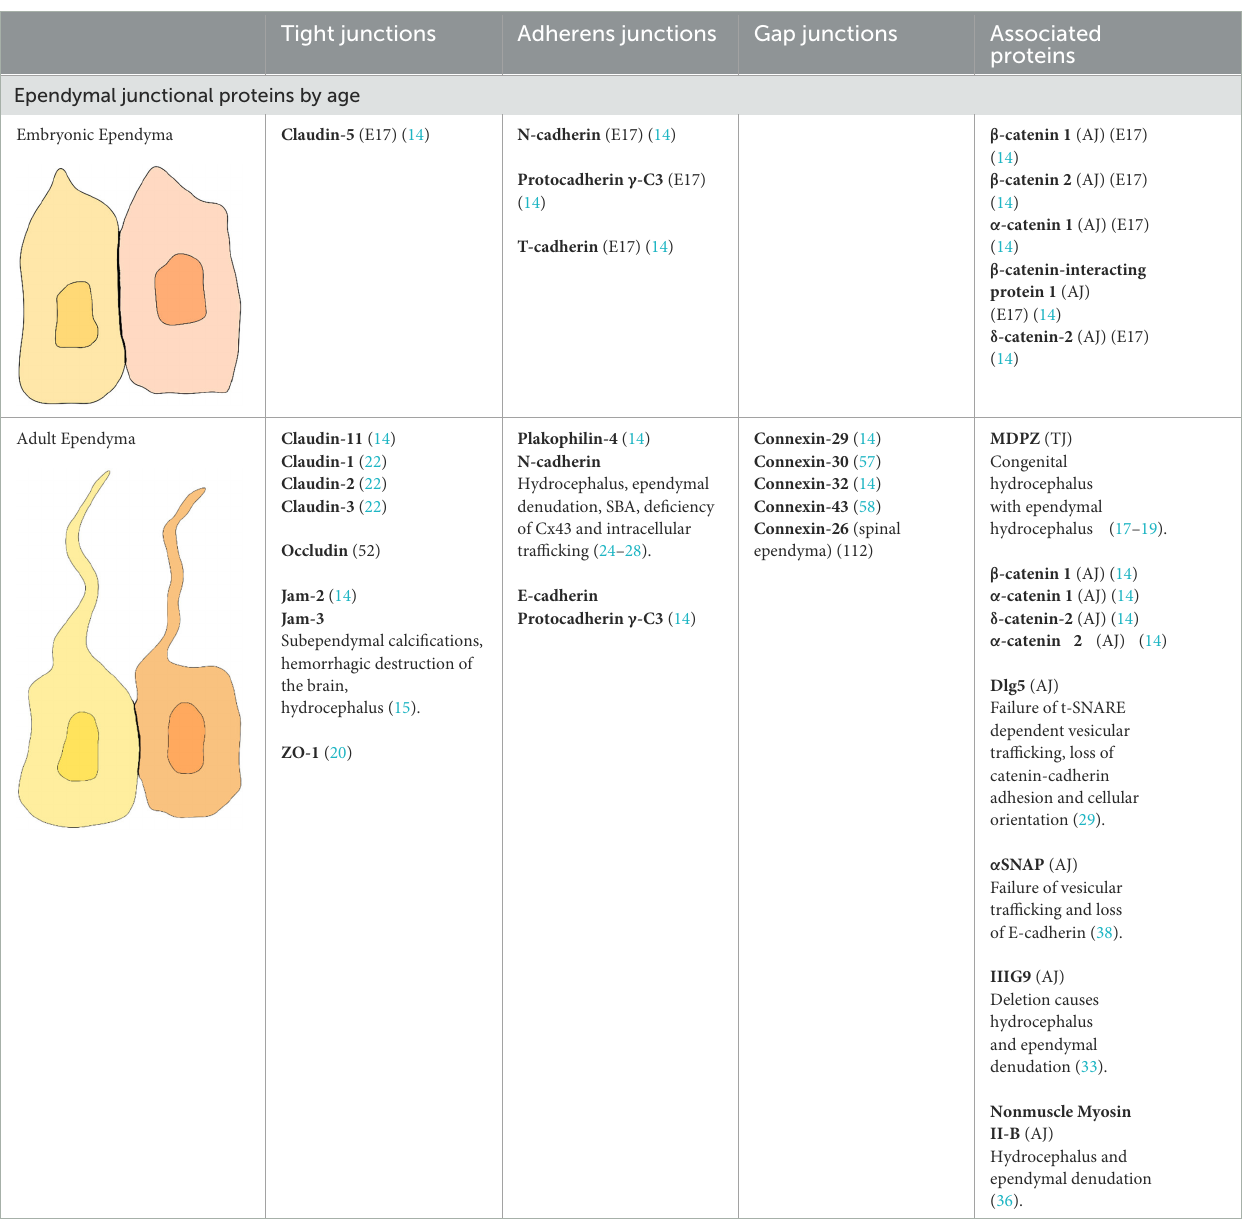
TABLE 2 Main proteins identified in the ependymal intercellular junctions. Tight junctions Adherens junctions Gap